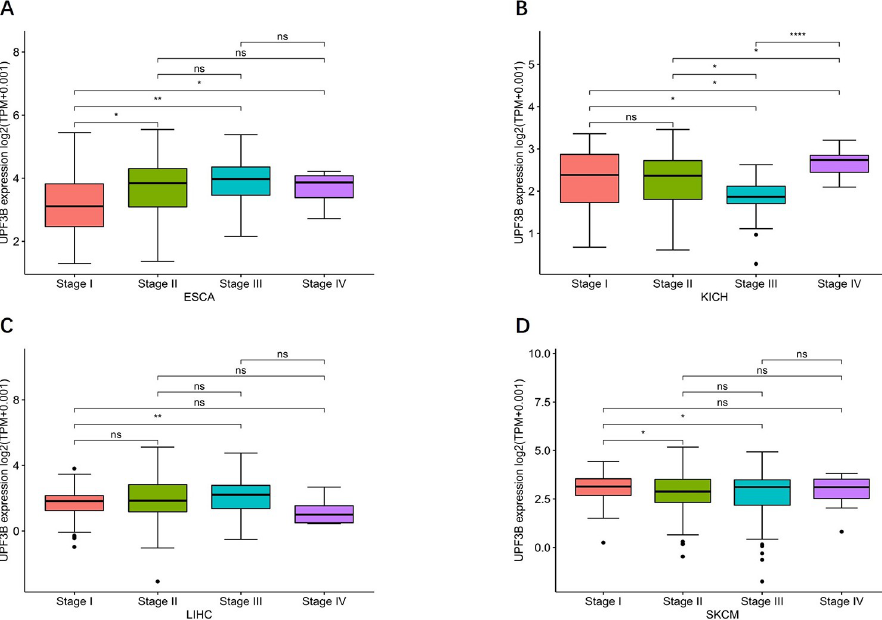
Fig 3. Association between UPF3B expression and tumor stages. (A) Esophageal carcinoma (ESCA). (B) kidney chromophobe (KICH). (C)liver hepatocellular carcinoma (LIHC). (D) skin cutaneous melanoma (SKCM). Data was obtained via TCGA. � p < 0.05, �� p < 0.01, ��� p < 0.001, ���� p < 0.0001.